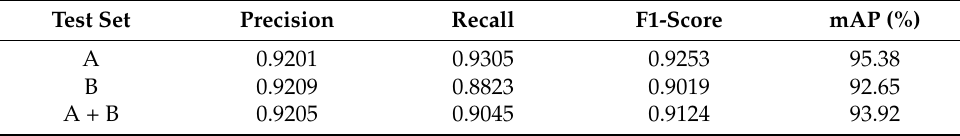
Table 3. Comparison of detection results of wheat ears with different degrees of occlusion.